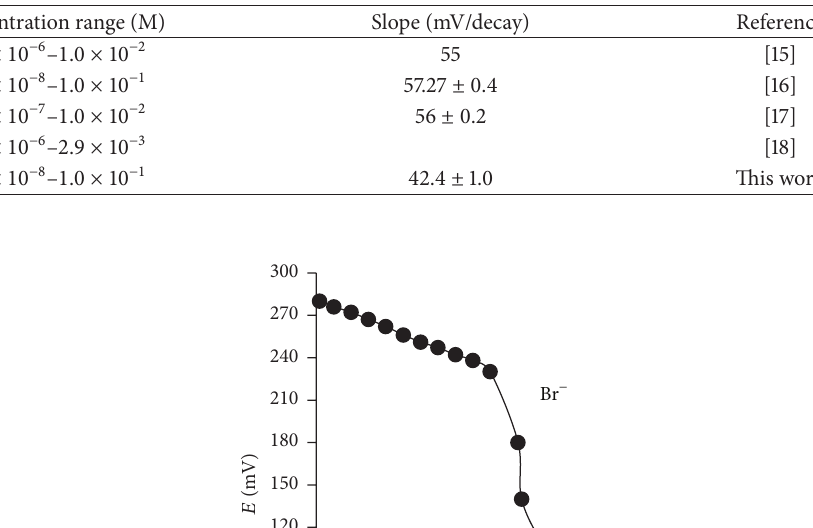
Table 4: Comparison study of CPE8 with previously reported electrodes.